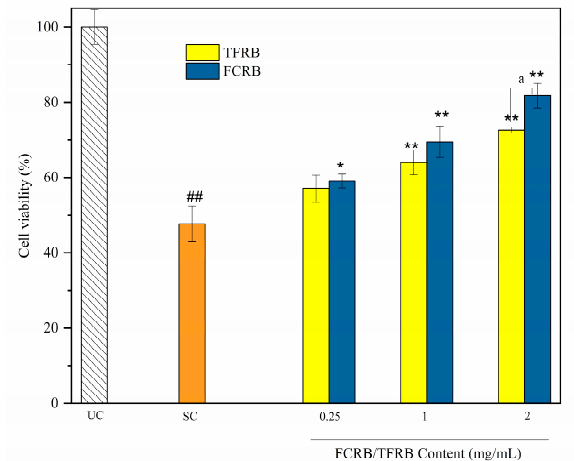
Figure 2. MTT assays of FCRB or TFRB effects on cytotoxicity in Caco-2 cells with H 2 O 2 -induced oxidative stress. UC, untreated controls; SC, stress controls treated with 1 mM H 2 O 2 only. The results are presented as means ± SD ( n = 3). ## p < 0.01 vs. UC; * p < 0.05, ** p < 0.01 vs. SC; a p < 0.01 vs. the TFRB (at the same concentration) as determined using the one-tailed t test.